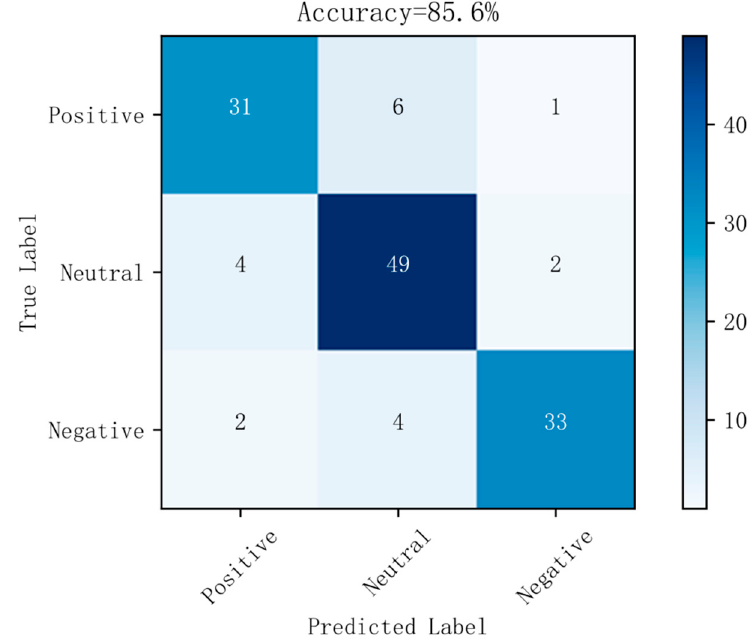
Figure 9. Confusion matrix in differential entropy dataset based on LDA with SVM.